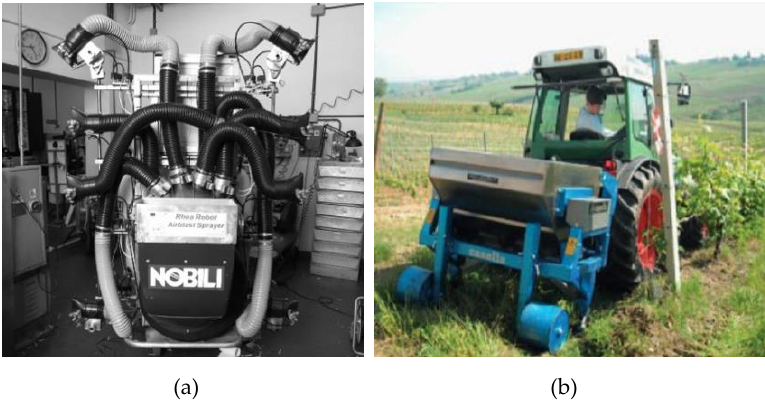
Figure 9. VRT machines: ( a ) VRT sprayer [67] (reproduced from [67] with permission from Ist Int. Workshop Vineyard Mech. Grape Wine Qual. Piacenza Acta Hortic , 2013; ( b ) VRT fertilizer (reproduced from [69] with permission from Universitat Politecnica de Valencia , 2015).